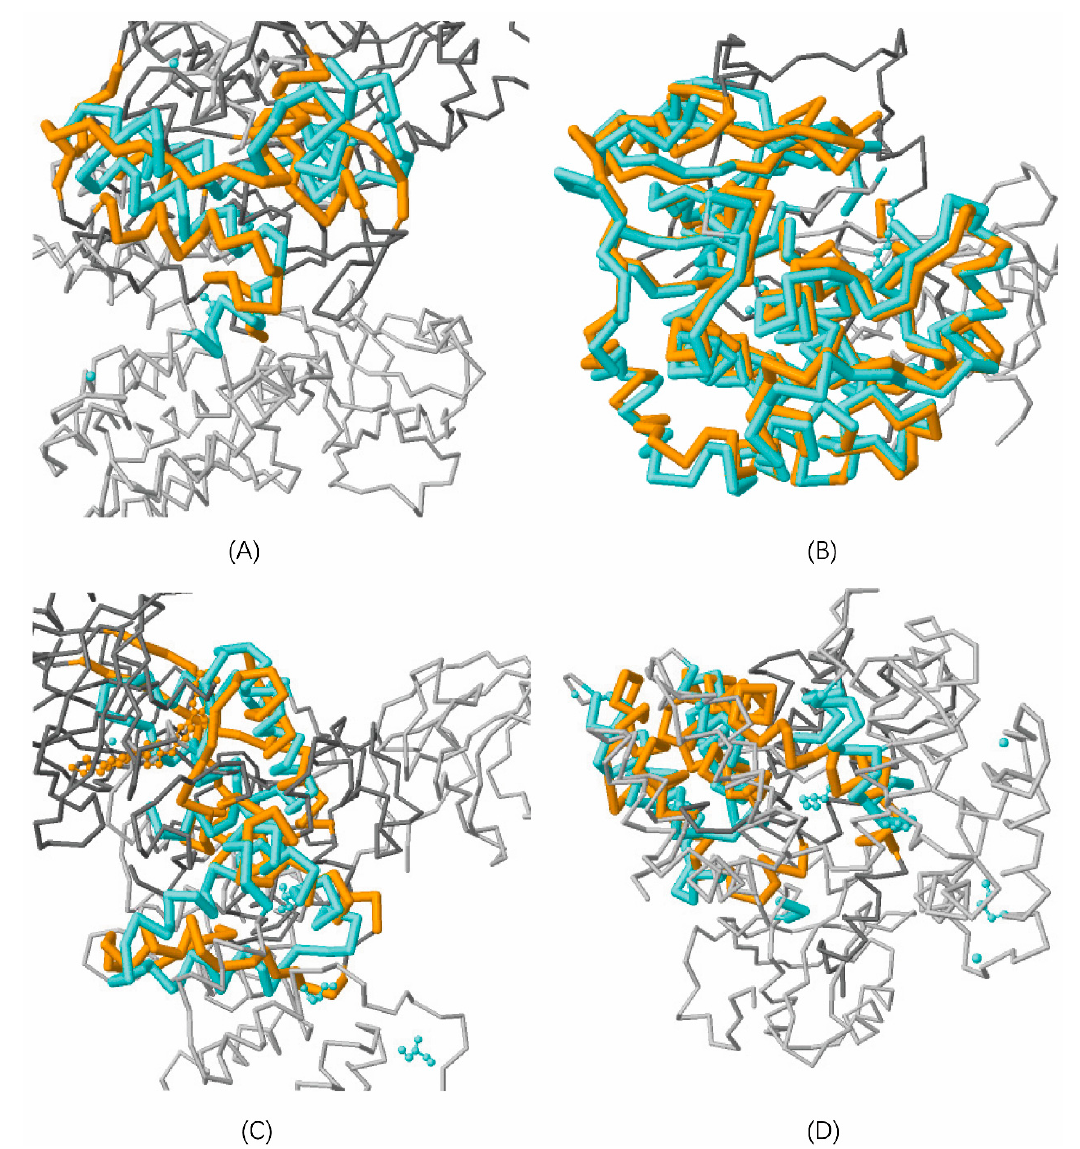
Figure 1. Paralog structural comparisons of two non-interacting proteins. ( A ) illustrates the structural alignment between protein pair (PKN1, RPS6KA1) that do not interact with Z-score equal to 1.99, identity equal to 2.75%, and similarity equal to 9.89%; ( B ) illustrates the structural alignment between paralog (PKN1, AKT1) with Z-score equal to 6.35, identity equal to 39.00%, and similarity equal to 55.67%; ( C ) illustrates the structural alignment between Neglog (AKT1, RPS6KA1) with Z-score equal to 1.99, identity equal to 4.35%, and similarity equal to 10.33%; ( D ) illustrates the structural alignment between a random protein BAD and RPS6KA1 (BAD, RPS6KA1) with Z-score equal to 3.70, identity equal to 4.38%, and similarity equal to 13.14%.